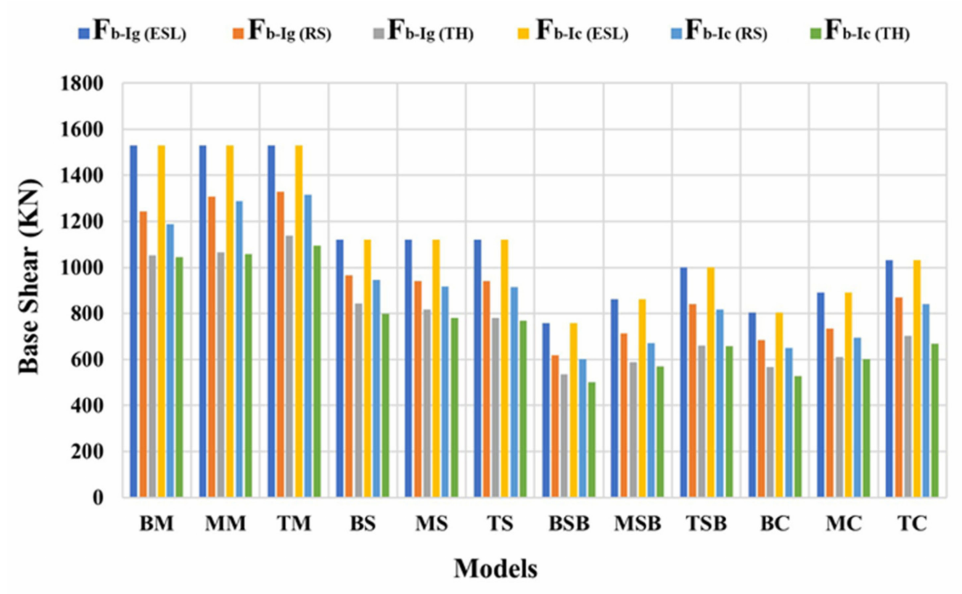
Figure 9. Base shear force for different locations of structural